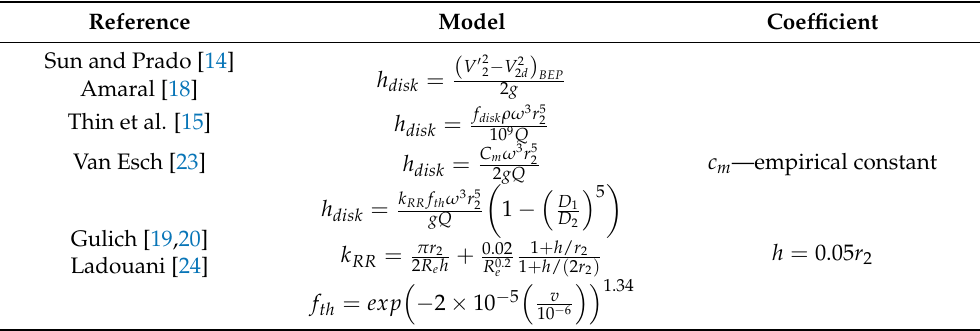
Table 6. Disk loss models in